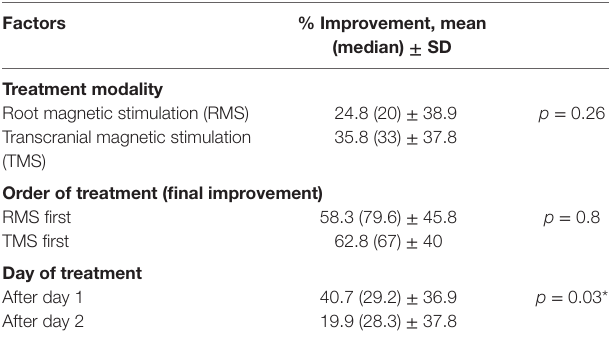
TaBle 3 | Multifactorial ANOVA.